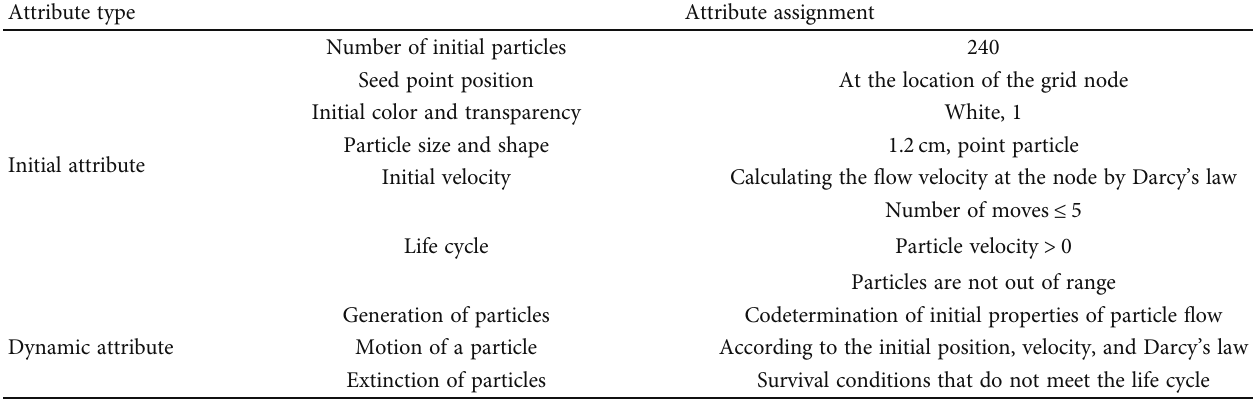
Table 1: Attribute assignment table for particle fl ow visualization.